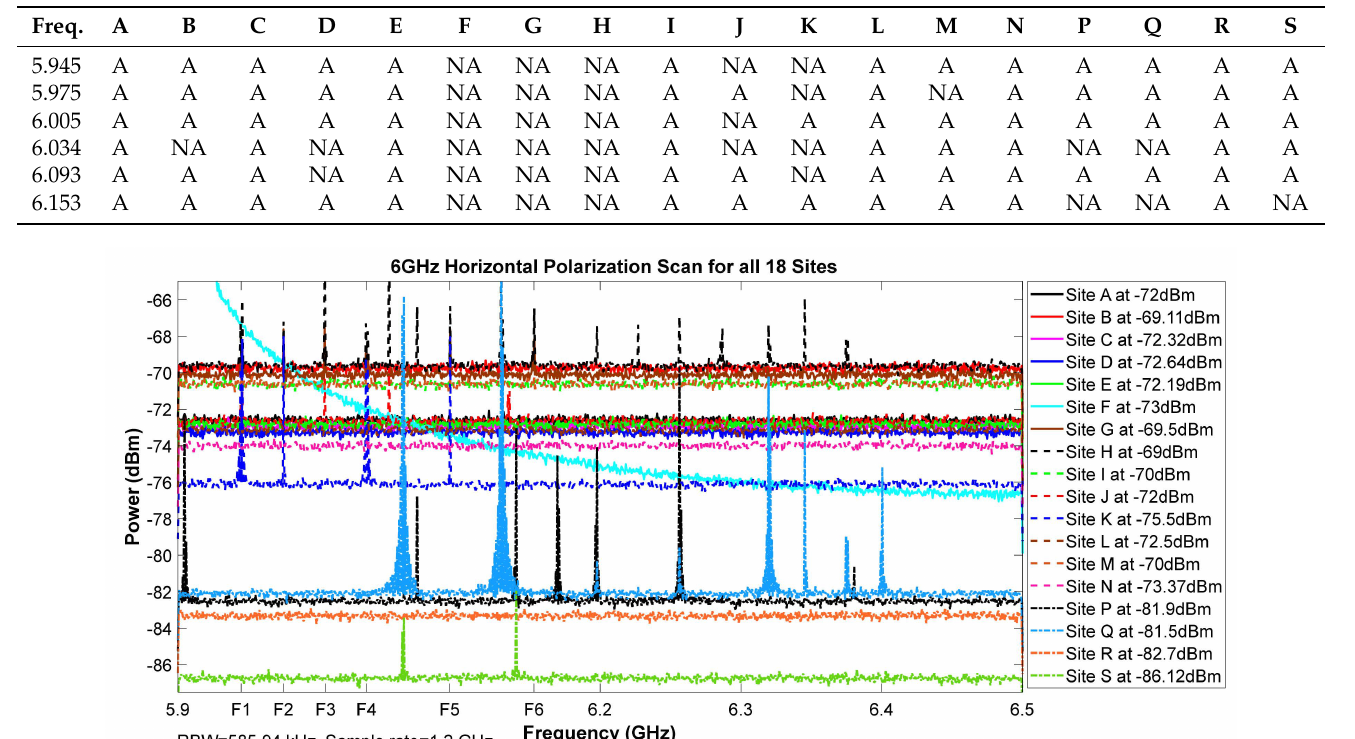
Figure 5. 6 GHz horizontal polarization scan for all 18